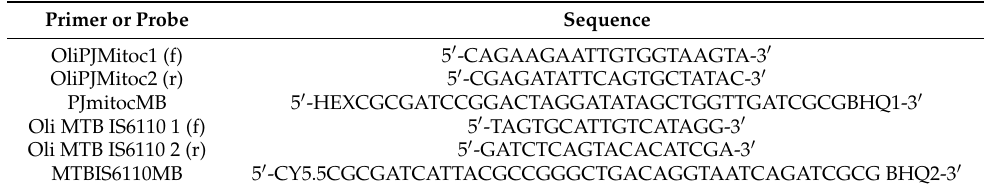
Table 2. Sequences of primers and probes designed for P. jirovecii and M. tuberculosis complex